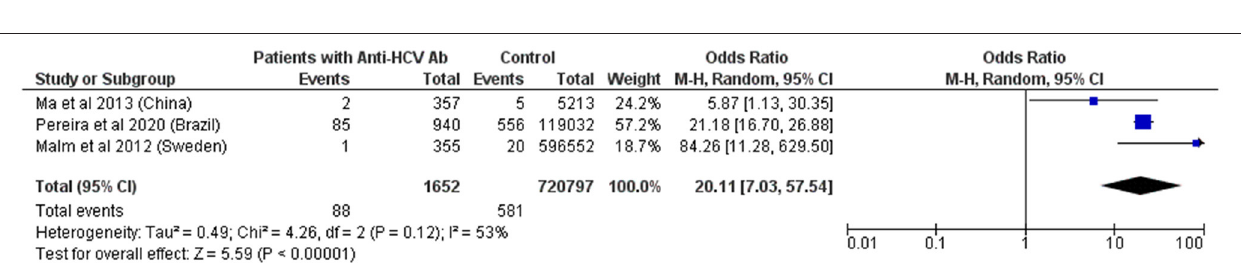
FIGURE 5 | Forest Plot and meta-analysis showing the Odds Ratio HPV infection in people living with HTLV-1. The boxes and lines indicate the odds ratios (ORs) and their confidence intervals (CIs) for each study. The pooled odds ratio is represented by a black diamond. The size of the blue squares indicates the relative weight of each estimate. Statistical analysis and graph were performed using RevMan 5 Software. Odds Ratio was calculated using Random effects model and Mantel-Haenszel statistical method. Measures of heterogeneity between studies is shown.